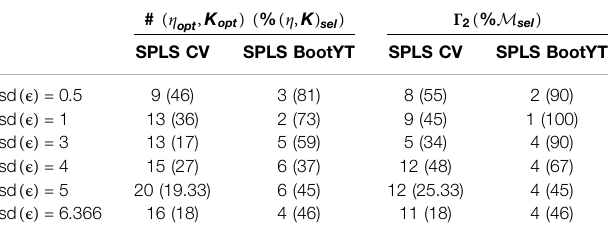
TABLE 5 | Results for SPLS model